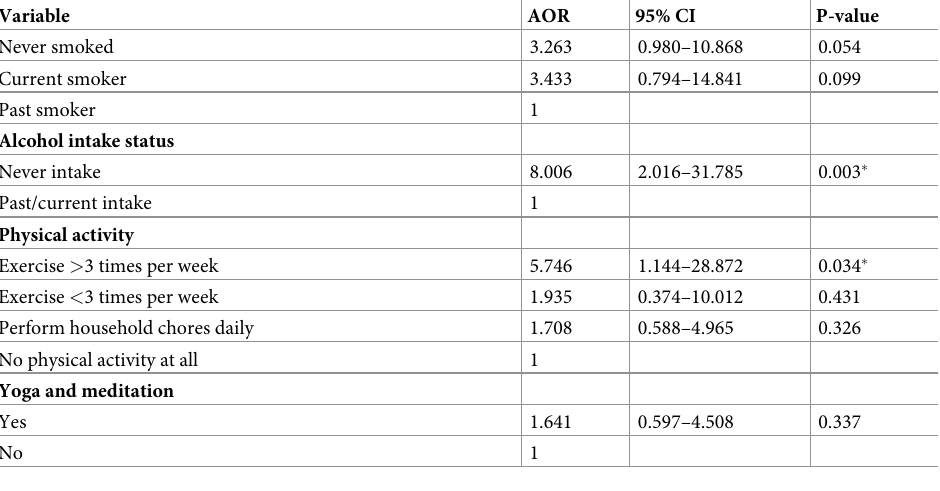
binary logistic regression analysis. For example, on multivariate analysis, women with second- ary education were more likely (AOR = 5.779, 95% CI: 2.029–16.459) to have a good quality of life compared to illiterate women. Similarly, women who had taken medication or treatment for the problems were more likely (AOR = 4.828, 95% CI: 1.662–14.023) to have a good quality of life compared to women who hadn’t taken medication or treatment. Furthermore,